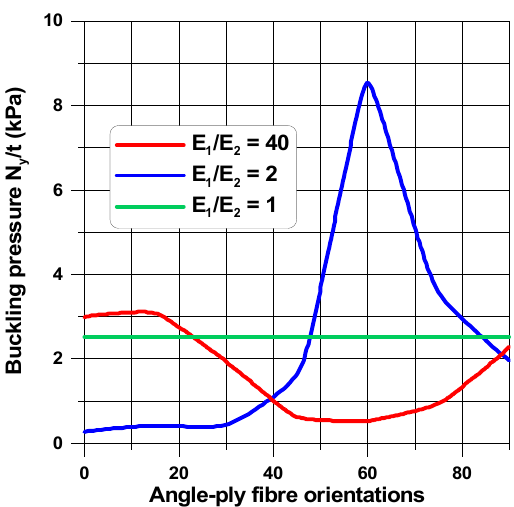
Figure 12. Distributions of buckling loads with fibre orientations ( θ ) and the orthotropic parameter, β = E 1 / E 2 , G 12 / E 1 = 0.015 for the rectangular plate ( L x / L y = 1.25) with the elliptical horizontal hole 2 b / L x = 0.16, b / a = 2.